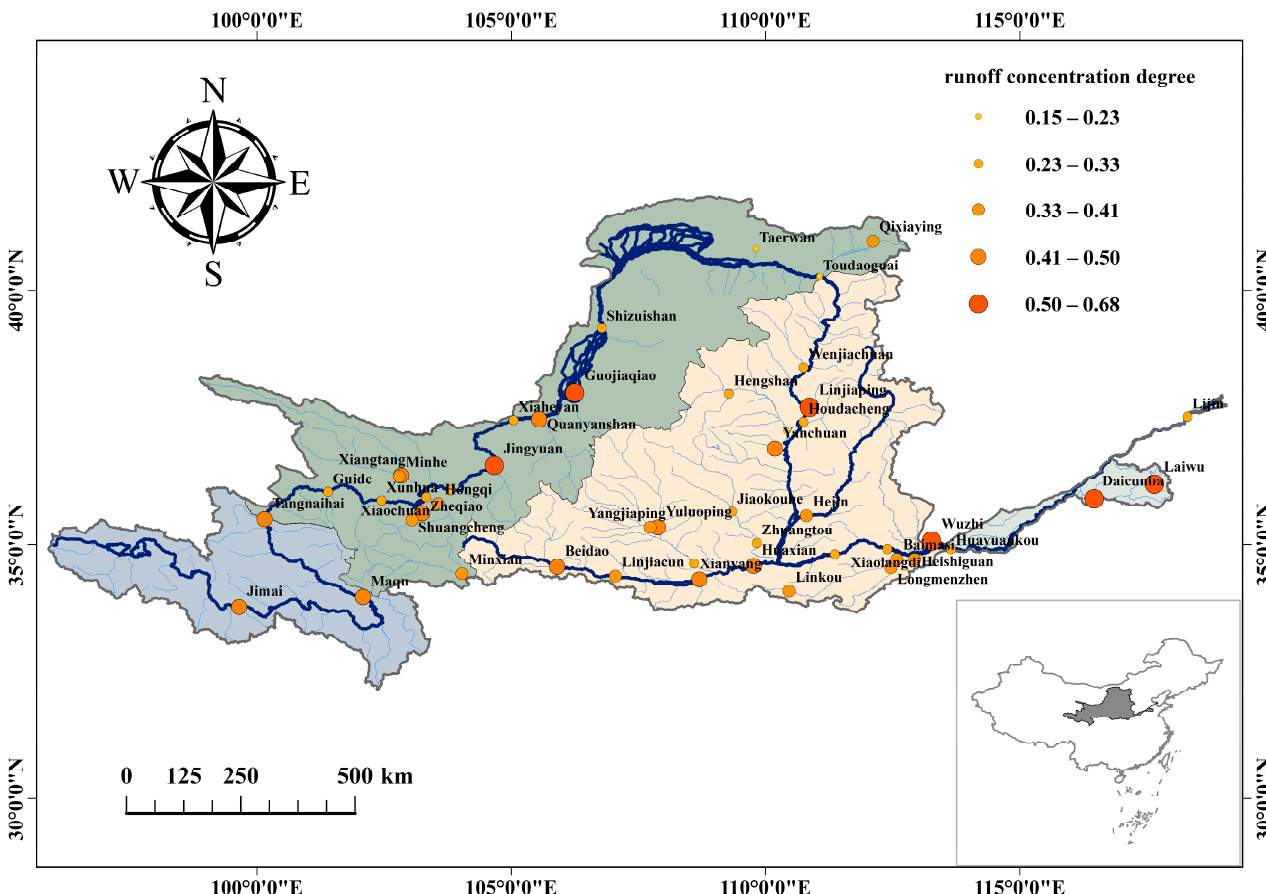
Figure 4. The annual average concentration of runoff from the main control sections of the Yellow River Basin.